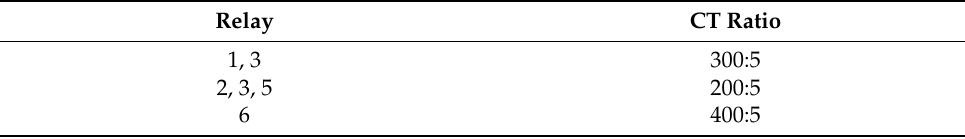
Figure 15. IEEE 3-bus system. Table 14. CT ratios of the relay (IEEE 3-bus system).